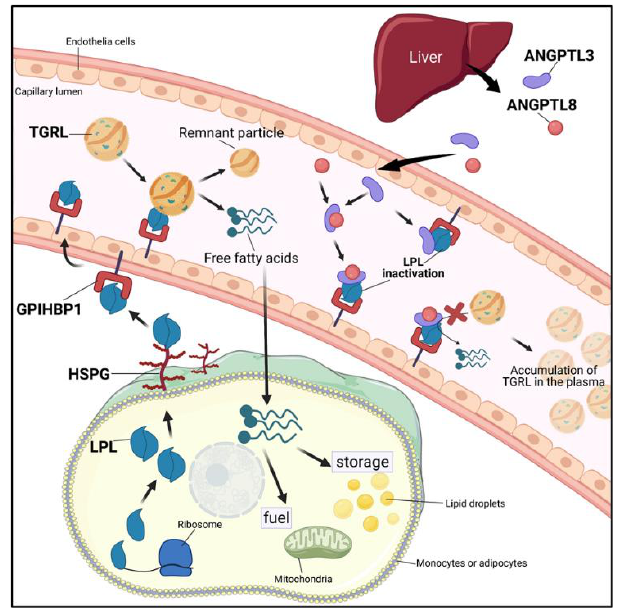
Figure 3. Overview of the role of ANGPTL3 in LPL inhibition and TGRL metabolism. Dietary lipid is transported via the blood as part of TG-rich lipoproteins (TGRLs) such as chylomicrons and VLDL, and the TGs are hydrolyzed by lipoprotein lipase (LPL). LPL is synthesized by myocytes or adipocytes and transferred to the cell surface by heparan sulfate proteoglycans (HSPGs). LPL is further transported to the glycosylphosphatidylinositol-anchored high-density lipoprotein bind- ing protein 1 (GPIHBP1) upon the capillary endothelium. ANGPTL3 and ANGPTL8 proteins are produced and secreted by the liver. The ANGPTL3 protein alone or forming a functional complex with ANGPTL8 could markedly inhibit LPL activity (created with BioRender.com, accessed on 2 July 2021).